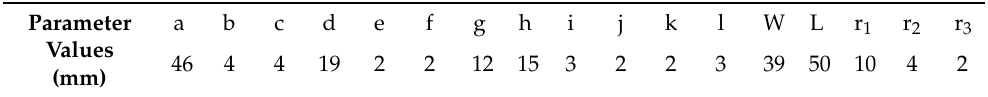
Figure 1. ( a ) Schematic of the split ring resonator loaded MIMO antenna. ( b ) The top (red) and bottom (yellow) layer structure is considered conductive copper material on FR4 substrate. Table 1. Antenna design parameters.